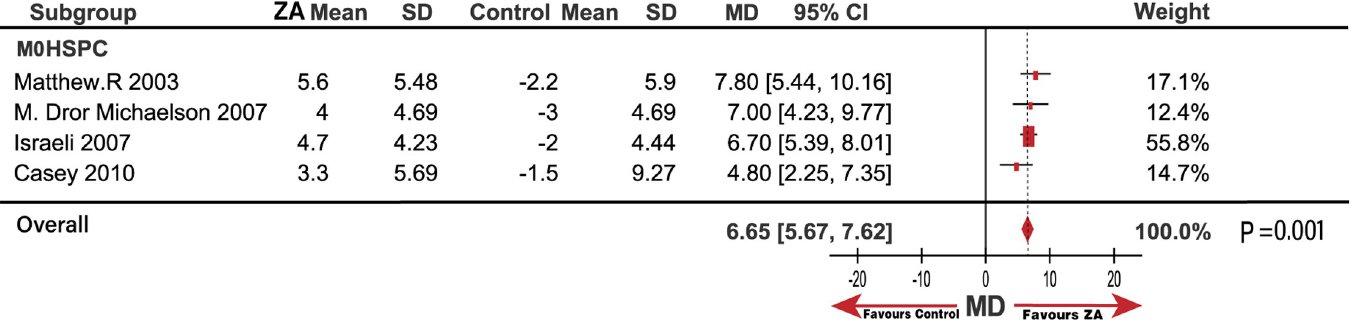
PLOS ONE | https://doi.org/10.1371/journal.pone.0275176 September 22,